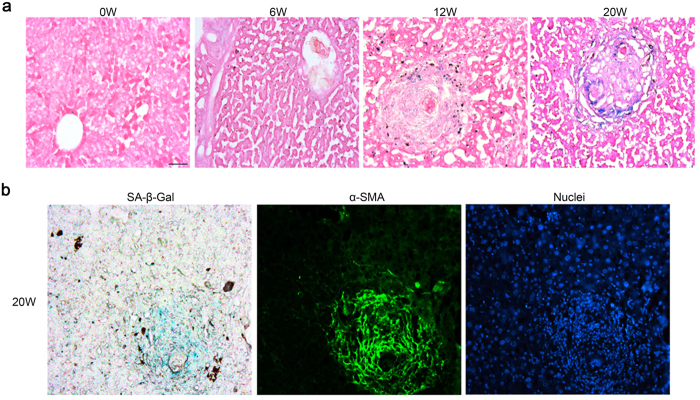
Cell senescence occurs at the advanced stage of S. japonicum infection.(a) Counterstaining of SA-β-Gal staining (blue) and hematoxylin-eosin staining (red) of liver infected with S. japonicum. (b) Counterstaining of SA-β-Gal staining (blue) and immunofluorescence of α-SMA (green). Bar: 50 micrometers.